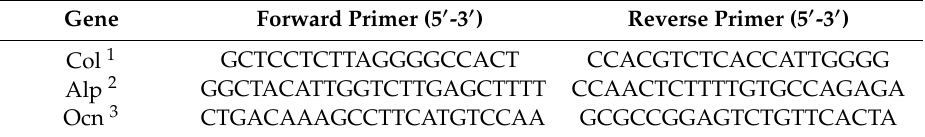
Table 1. Primer sequences for the reverse transcriptase–polymerase chain reaction